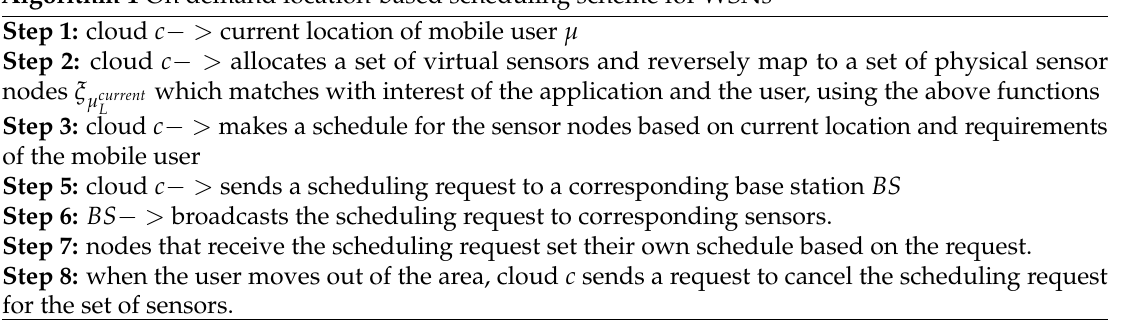
Algorithm 1 On demand location-based scheduling scheme for